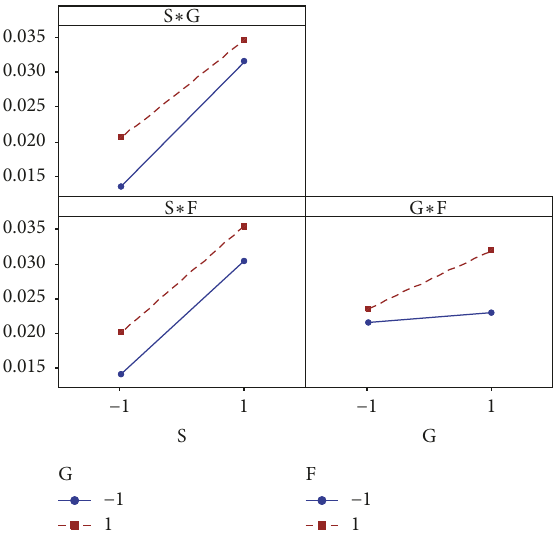
Figure 7: Diagram of interactions for absorbance (S: sucrose; G: glucose; F: